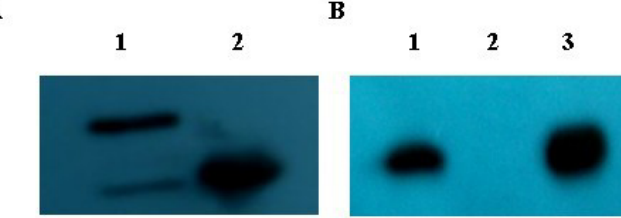
Figure 3. GST pull-down analysis of the interaction between His-tagged SelM' and GST-Gal-1. ( A ) Western blot (WB) analysis of the expression of GST and GST-Gal-1 with GST antibody. Lane 1 , GST-Gal-1 (42 kDa); lane 2 , GST (27 kDa); ( B ) GST